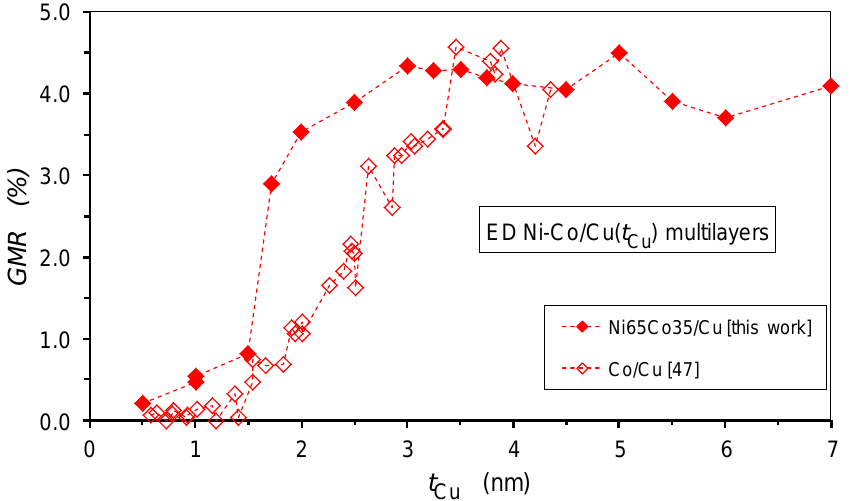
Figure 18. Comparison of the evolution of the GMR with spacer layer thickness t Cu for the present Ni 65 Co 35 /Cu multilayers and for our previous Co/Cu multilayer study [47]. To understand this difference, we should first consider the layer formation process in these multilayers. At low coverages, the Cu layer formation on the Co and Ni-Co layers proceeds with the nucleation of small islands (so-called Volmer-Weber growth mode [91]). This is partly due to the larger atomic size of Cu with respect to Ni and Co, in addition to the lack of a large attractive (Ni,Co)-Cu atomic interaction compared to the Cu-Cu one. However, the nucleation of Cu islands is somewhat easier on a Ni-Co surface with sufficiently high Ni content compared to a pure Co surface, which can be explained by the complete miscibility of Ni and Cu as opposed to the immiscibility of Co and Cu. Therefore, on a Ni 65 Co 35 surface, an initial Cu layer can nucleate with islands of larger lateral sizes than on a pure Co surface; thus, the Cu layer can become continuous by the coalescence of Cu islands at a smaller average Cu coverage on a Ni-Co alloy surface. The nucleation of Cu on pure Co is so effectively hindered that the transition to a continuous Cu layer is strongly smeared out in contrast to the more favored nucleation on a Ni 65 Co 35 surface, where this transition can occur in a fairly narrow Cu layer thickness range as demonstrated by the present results.